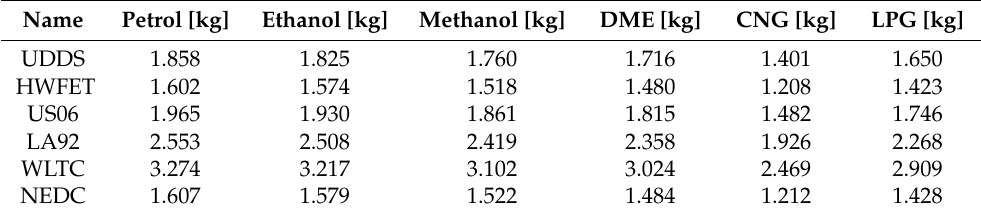
Table 10. Summary of the final CO 2 emissions per kilometer travelled obtained from the simulations of the 2018 Toyota Camry LE vehicle for selected road tests.